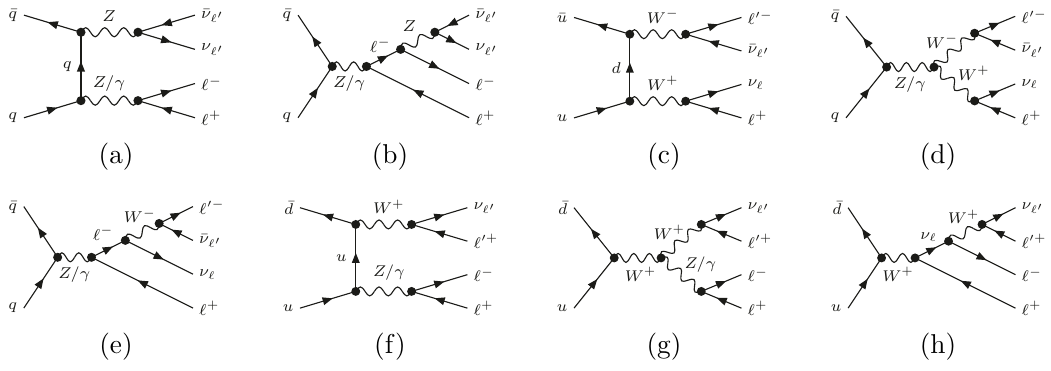
Figure 1 . Sample LO diagrams for 2l-SF-ZZ (a-b), 2l-DF-WW (c-e), and 3l-DF-WZ (f-h).